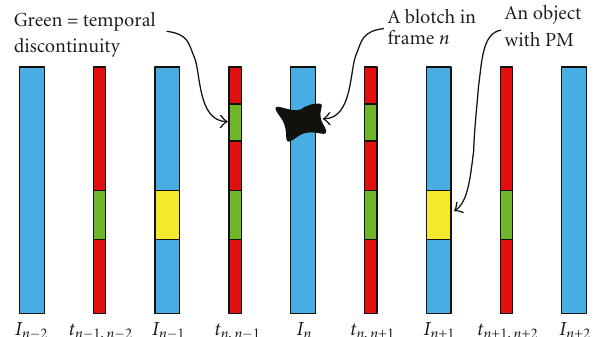
Figure 2: This figure illustrates the arrangement of the five frames window for blotch detection (in blue). The window is centred on frame n ( I n ) which is the frame on which blotch detection is to be performed. Between the five frames, four temporal discontinuity fields ( t ∗ , ∗ ) (in red) can be estimated between pairs of consecutive frames. In this diagram a blotch is present on frame n and the yellow object is occluded in every second frame (an example of PM). Due to the pattern of occlusion it is impossible to distinguish between the blotch and the object when detecting blotches based on temporal discontinuities over a three-frame window. By extending the window it is possible to perform a correct